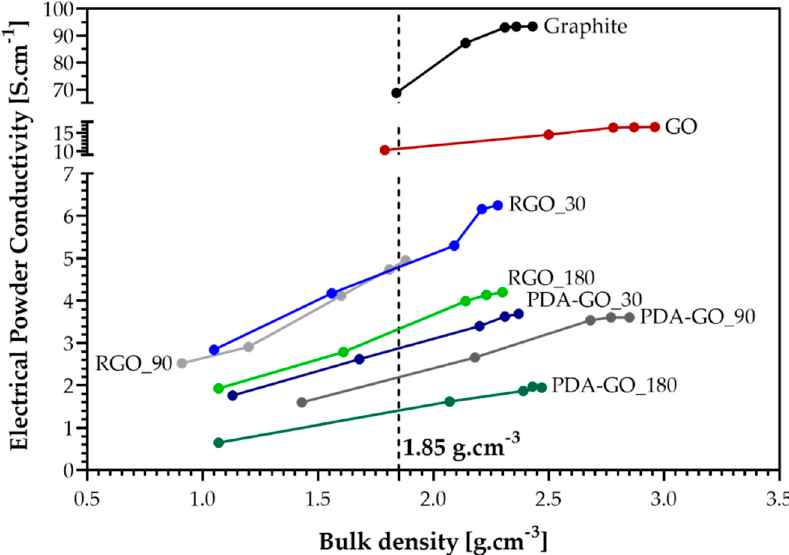
Figure 10. Dependency of electrical conductivity of the powdery materials on bulk density (density increases with pressure).